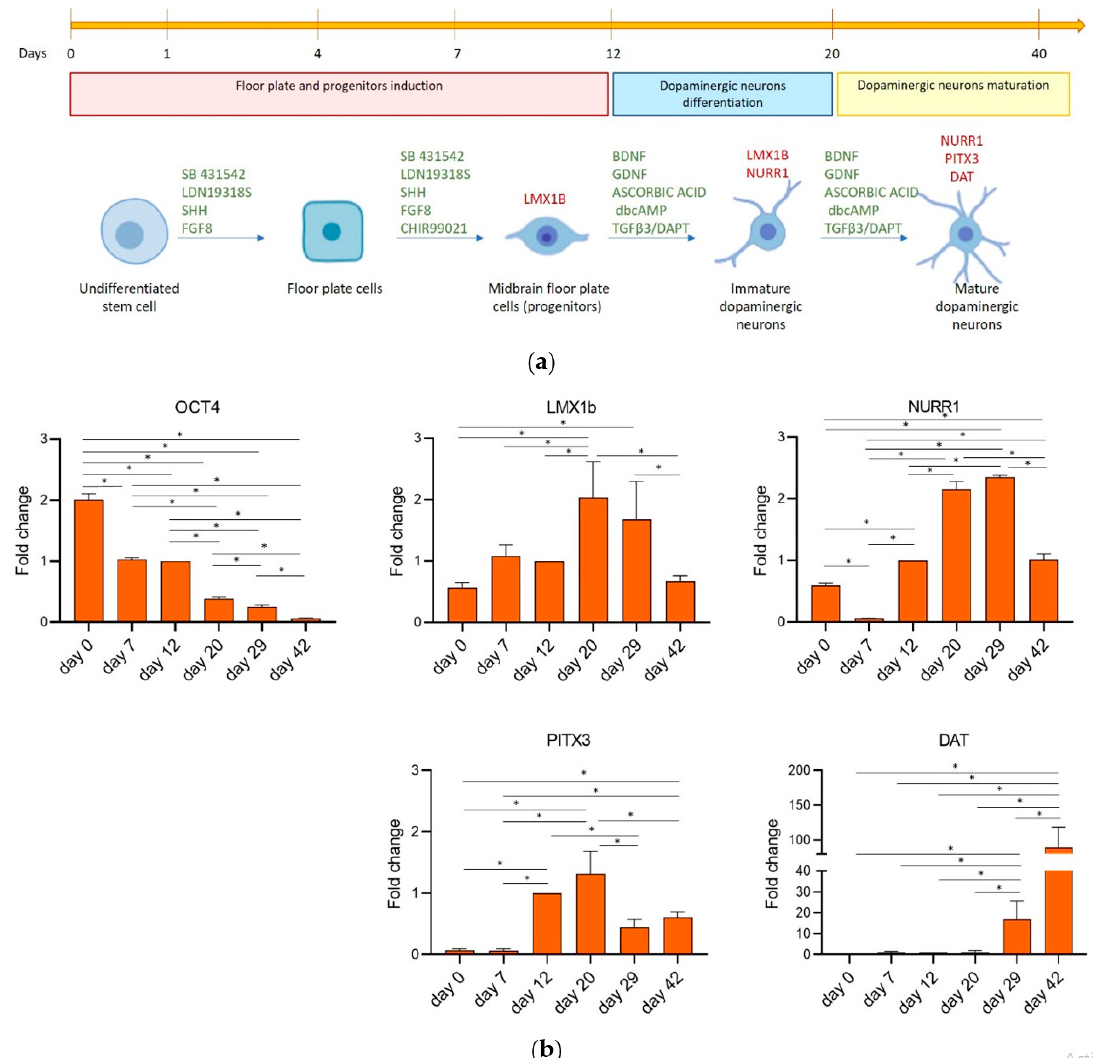
Figure 3. Gene expression analysis of molecules selectively involved in DA neuron differentiation. ( a ) Schematic representation of key points of dopaminergic differentiation. In green, the small molecules used for the activation / inhibition of pathways involved in the differentiation process, while in red are reported some of the genes activated at specific stages of DA neuronal differentiation. ( b ) Gene expression of LMX1b , NURR1 , PITX3 , and DAT was quantified in hFM-MSCs by qPCR at different time points of DA differentiation. The fold changes were expressed in relation to day 12. 18S was used as reference gene. The graphs show the mean ± SD of three independent experiments * p < 0.05.